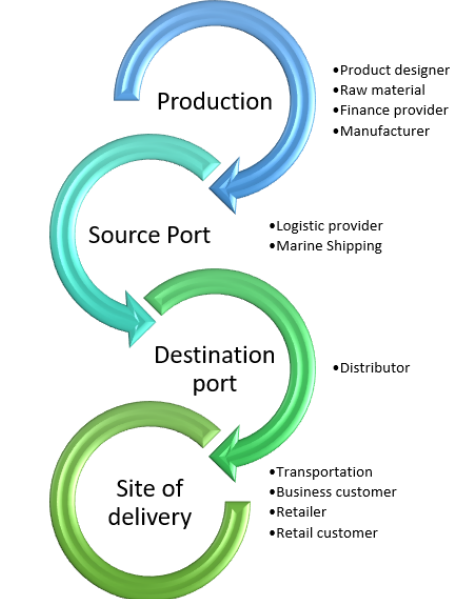
Figure 4. A simplified scheme of the supply chain elaborated by the